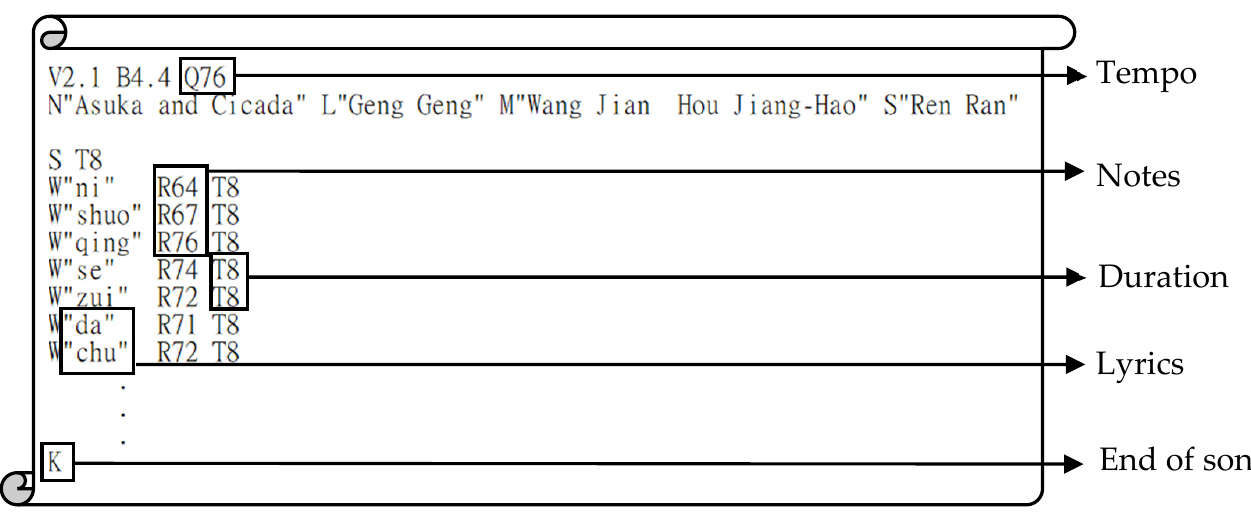
Figure 4. Two modes effects in the app, ( a ) Synchronous mode and ( b ) Asynchronous mode.